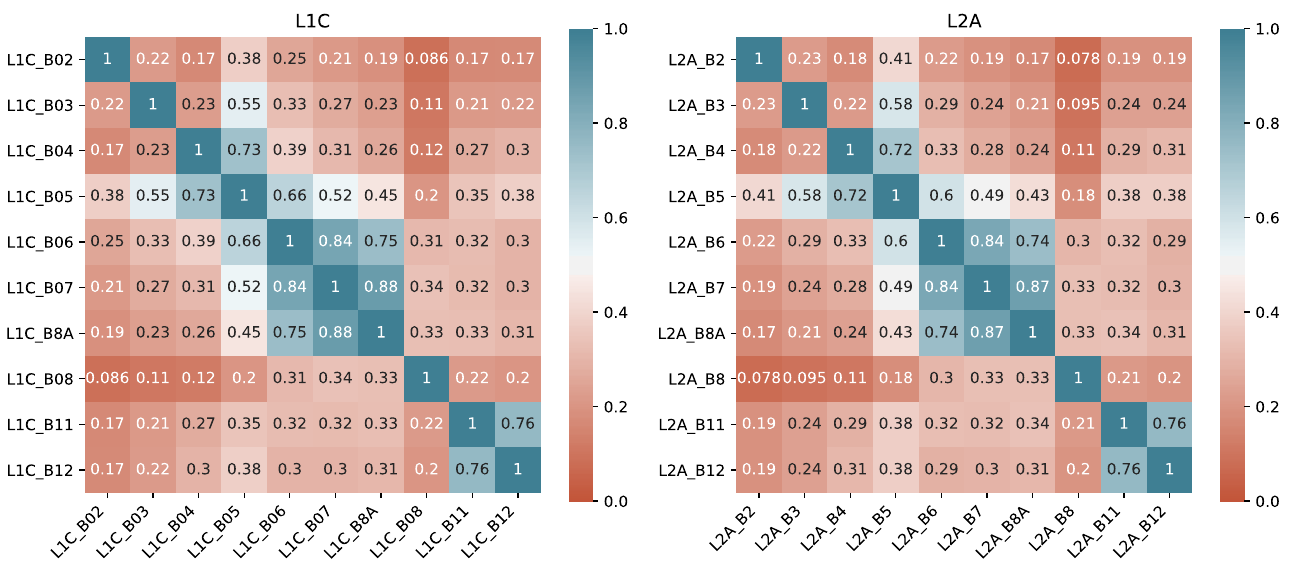
Figure 5. Normalized mutual information.